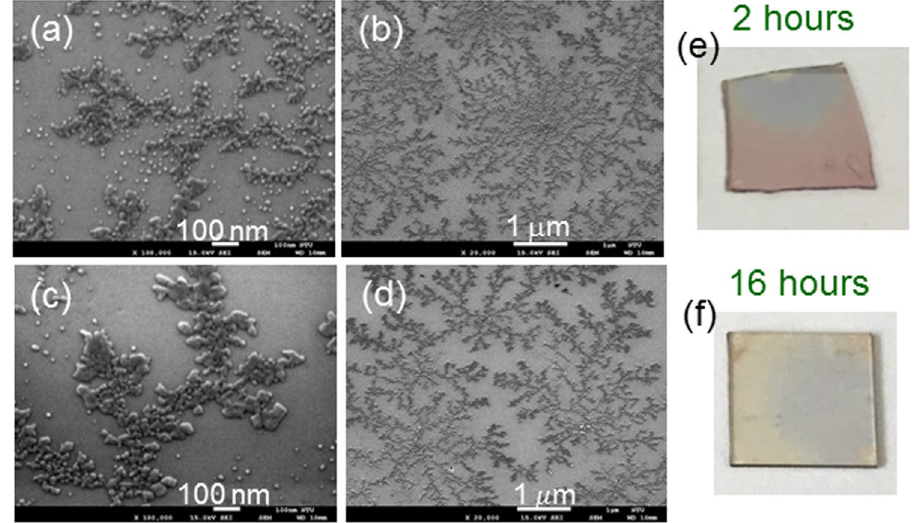
Figure 10. Results similar to Fig. 9 when ambient air humidity is increased to ~80%. ( a,b)[(c,d )] SEM images of different magnifications under the condition of 2- (16-) hour illumination. ( e,f ) Photographs of the samples with 2- and 16-hour illuminations,